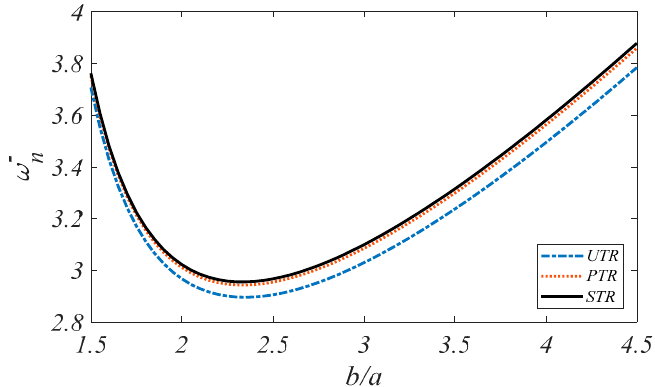
Figure 7. The e ff ect of temperature rising pattern on the nondimensional natural frequency of Figure 7. The effect of temperature rising pattern on the nondimensional natural frequency of MHCAP with clamp-clamp boundary conditions for di ff erent outer radius to inner radius ratios and MHCAP with clamp-clamp boundary conditions for different outer radius to inner radius ratios and h / b = 0.1, T i = 273 [K], T o = 300 [K], θ = π / 4, W CNT = 0.02, V F = 0.2, β = 1, FG-A, K p = 10 [MN / m], h/b = 0.1, T i = 273 [K], T o = 300 [K], θ = π /4, W CNT = 0.02, V F = 0.2, β = 1, FG-A, K p = 10 [MN/m], and K w = and K w = 100 [MN / m 3 ]. 100 [MN/m 3 ].